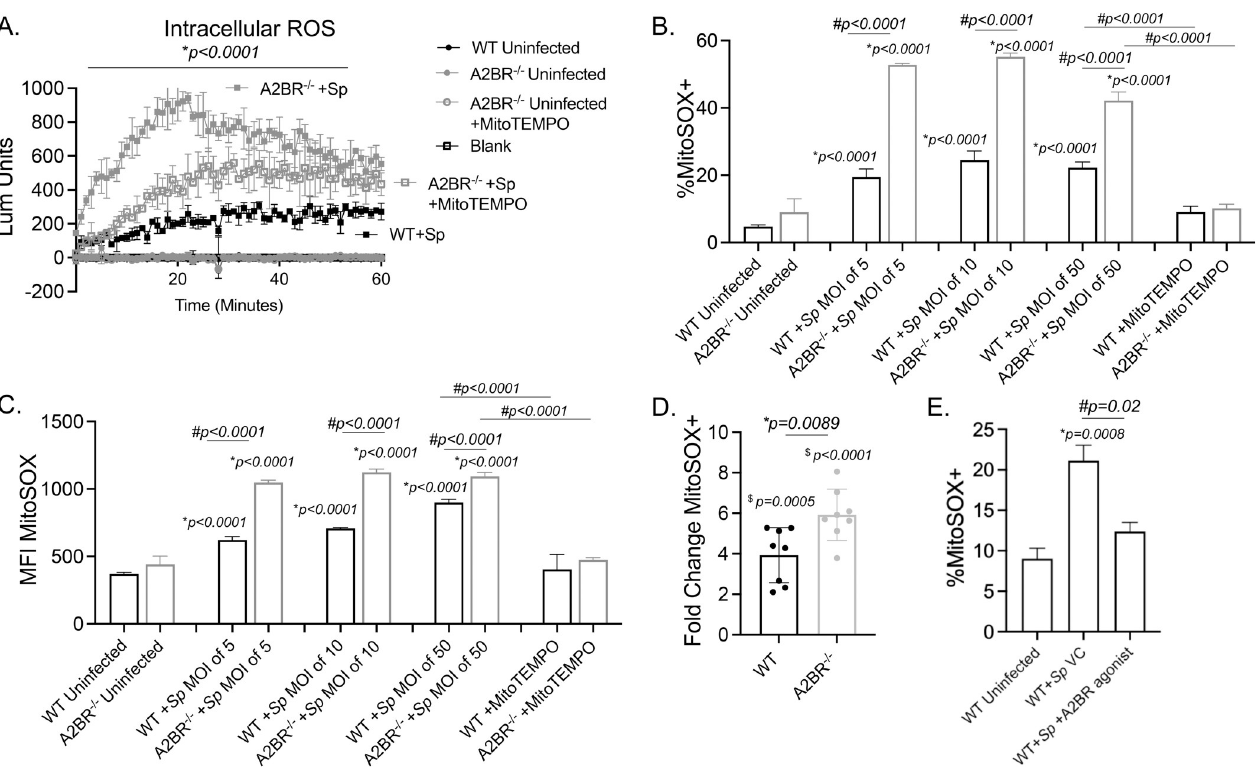
Fig 5. A2B adenosine receptor signaling blunts mitochondrial ROS production. (A) A2BR -/- (grey) and WT (black) bone-marrow derived PMNs were mock treated (uninfected) or infected with S . pneumoniae (+Sp) TIGR4 at a multiplicity of infection (MOI) of 50 in the presence or absence of MitoTEMPO. Cells were monitored for intracellular ROS production over 60 minutes using luminol. Data are representative from 1 of 3 experiments in which n = 3 technical replicates were used per condition. � indicates significant differences between infected A2BR -/- and WT controls as well as infected A2BR -/- +/- MitoTEMPO treatment as determined by 2-way ANOVA followed by Tukey’s multiple comparisons test. Line graphs represent the mean +/-SD. (B-C) WT (Black) and A2BR -/- (light grey) marrow-derived PMNs were infected with S . pneumoniae TIGR4 at the indicated MOIs for 10 minutes. +MitoTEMPO were treated with the drug prior to infection at an MOI of 50. (B) The % of MitoSOX+ cells as well as (C) the amount of MitoSOX produced (geometric MFI) were determined using flow cytometry. (B-C) Representative data shown are from 1 out of 8 separate experiments in which n = 3 technical replicates were used per condition. Bar graphs represent the mean +/-SD. � indicates significant differences from uninfected controls and # indicates significant differences between the indicated groups as measured by one-way ANOVA followed by Tukey’s multiple comparison test. (D) Fold increases in MitoSOX+ cells upon bacterial infection were calculated by dividing the values of infected conditions by uninfected controls for each mouse strain. Data pooled from eight separate experiments (n = 8 mice/ group) are shown. $ indicates significantly different from 1 as measured by one-sample t-test and � indicates significant differences between the indicated groups as measured by Student’s t-test. (E) WT PMNs were treated with vehicle control (VC) or the A2BR Agonist BAY60-6583 for 30 minutes. Cells were then mock-treated (Uninfected) or infected with S . pneumoniae TIGR4 at a MOI of 10 for 10 minutes. The % of mitochondrial ROS producing cells were determined by flow cytometry. Representative data shown are from 1 out of 5 separate experiments in which n = 3 technical replicates were used per condition. Bar graphs represent the mean +/-SD. � indicates significant differences from uninfected controls and # indicates significant differences between the indicated groups as measured by one-way ANOVA followed by Tukey’s multiple comparison